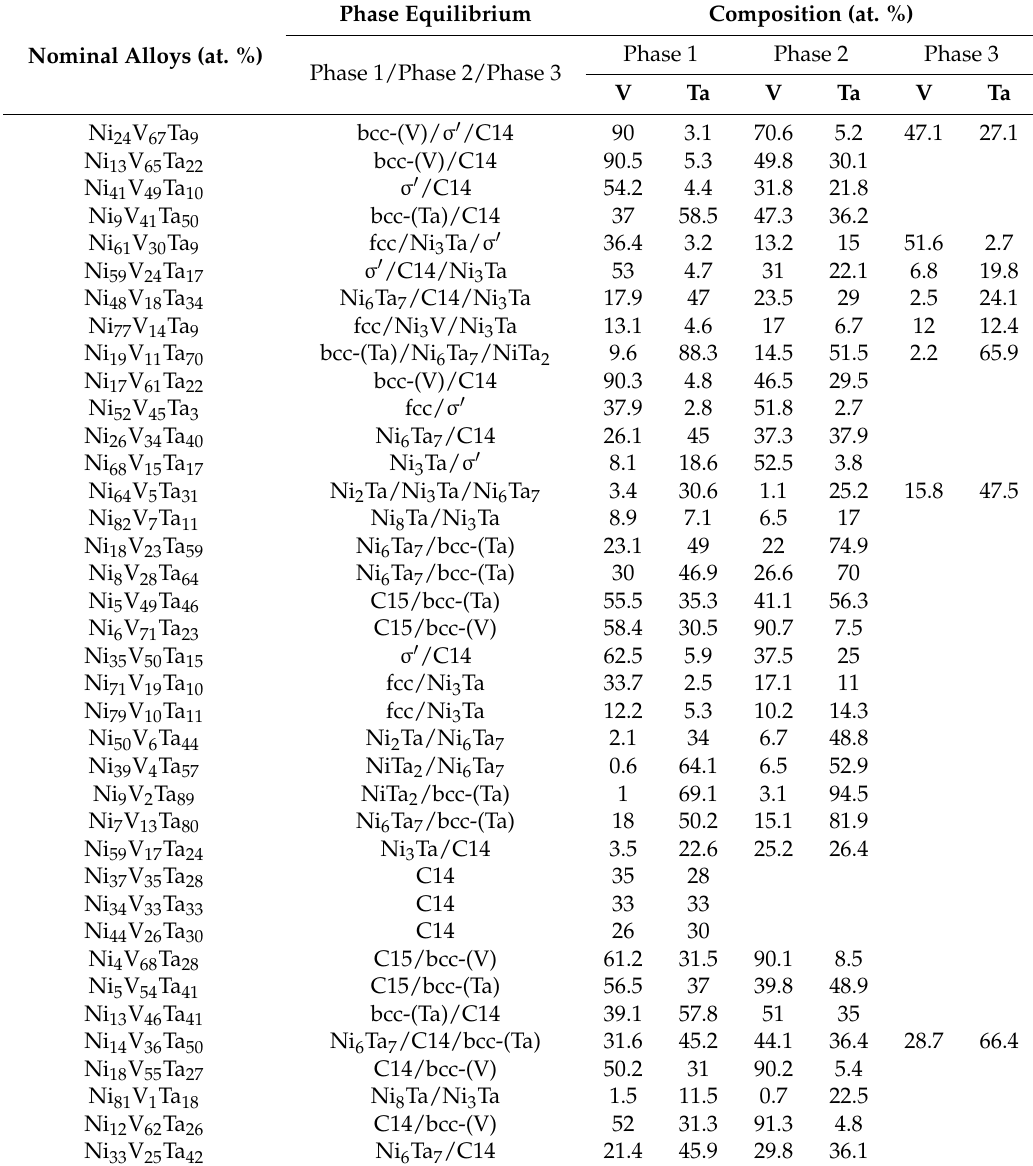
Table 2. Equilibrium compositions of the phase in the Ni-V-Ta ternary alloys annealed at 1000 ◦ C for 55